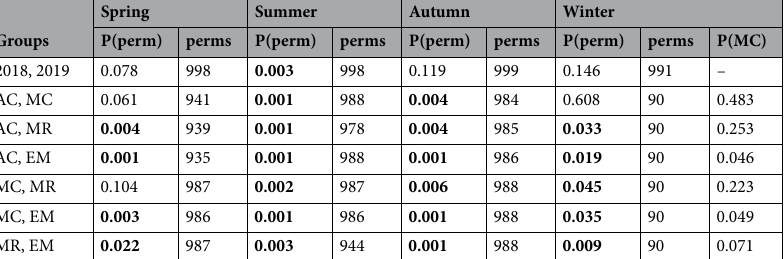
Table 4. Pairwise tests within the factors “Years × Season” (p = 0.023, Table 1) and “Site × Season”. “P(perm)”: permutation P-value, “perms”: number of permutations and “P(MC)”: Monte-Carlo p value. p -values smaller than 0.05 are presented in bold.